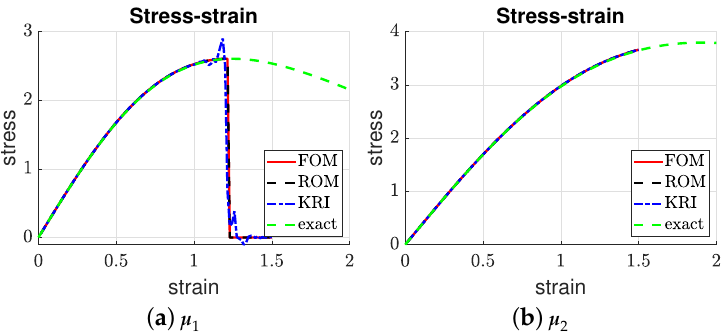
Figure 9. Strain field. Note that the Kriging model provided a maximum strain of only around 750 for µ . 1